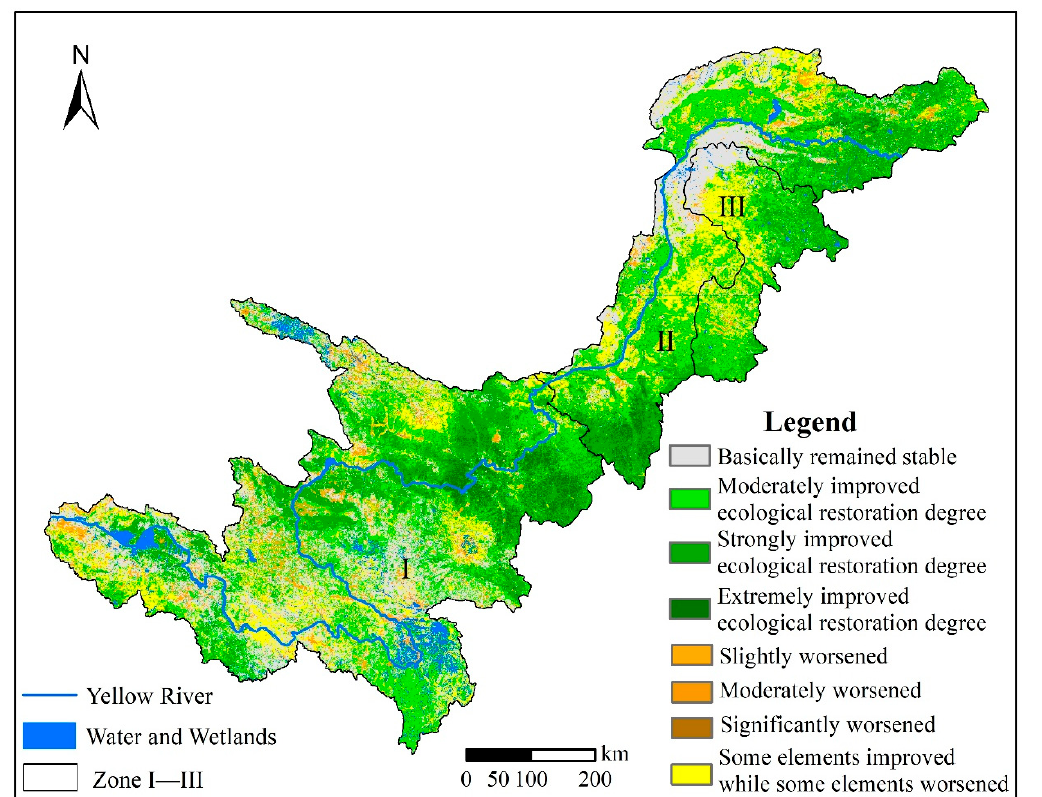
Figure 8. Spatial distribution of ecosystem restoration degrees in the Upper Yellow River region. Table 6. Statistical table reflecting ecological restoration changes in the study